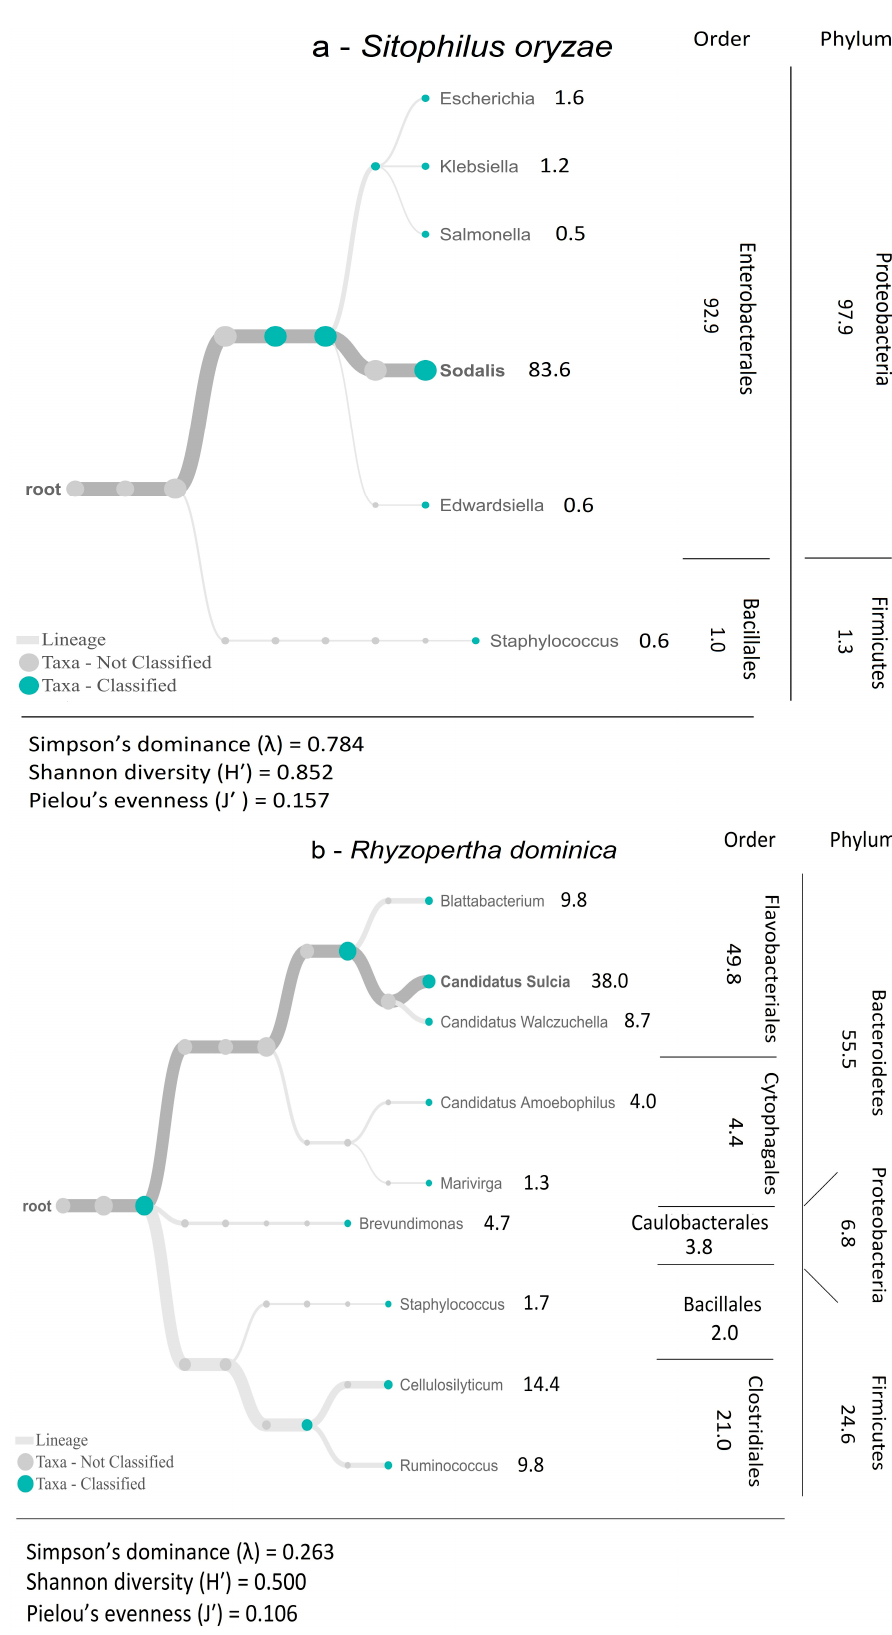
Figure 1. Results of nanopore 16S rRNA sequencing for the bacterial microbiome inhabiting the digestive system of ( a ) S. oryzae and ( b ) R. dominica.